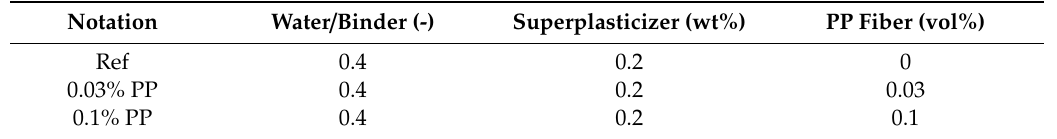
Table 2. Table 2. Proportions of grouts used in this Table 2. Proportions of grouts usеd in this study.